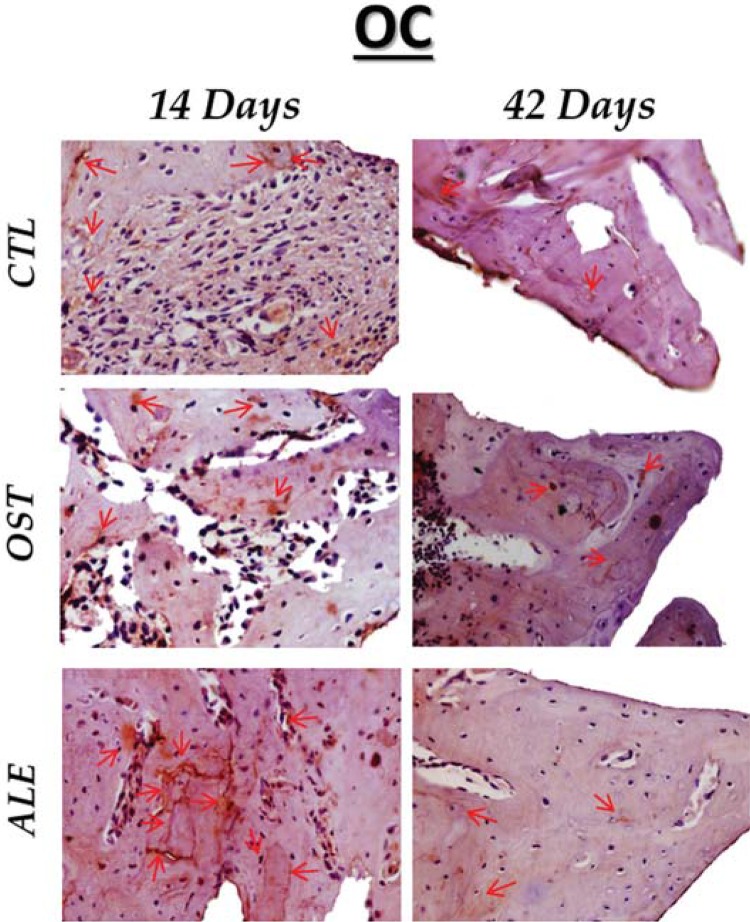
OC immunostaining at 14 days for the experimental groups (CTL: moderate; OST: light; ALE: moderate). At 42 days (CTL: moderate; OST: light; ALE: light). Immunolabeling indicated by red arrows. (Original, 40x)